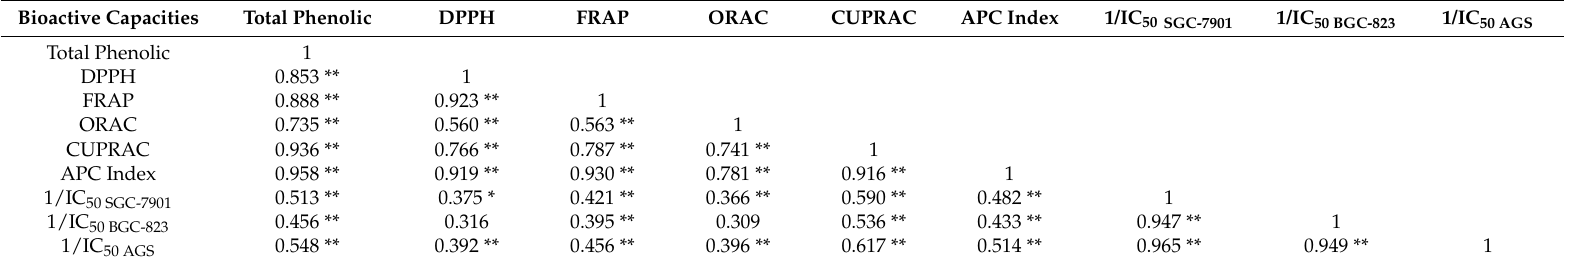
Table 8. Pearson’s correlation coefficients among total phenolics, antioxidant values and in vitro anticancer abilities in citrus flavedo.